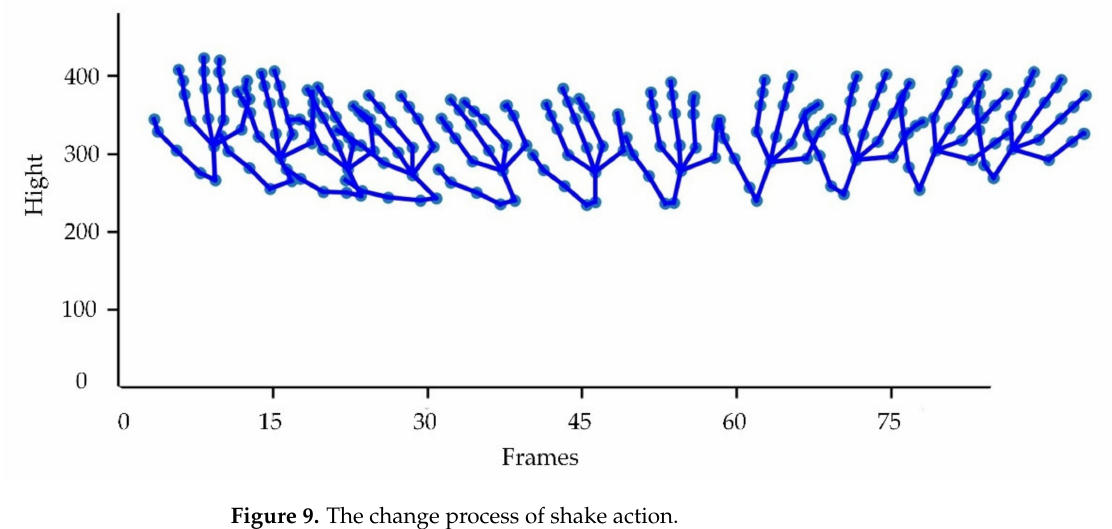
Figure 9. The change process of shake action.